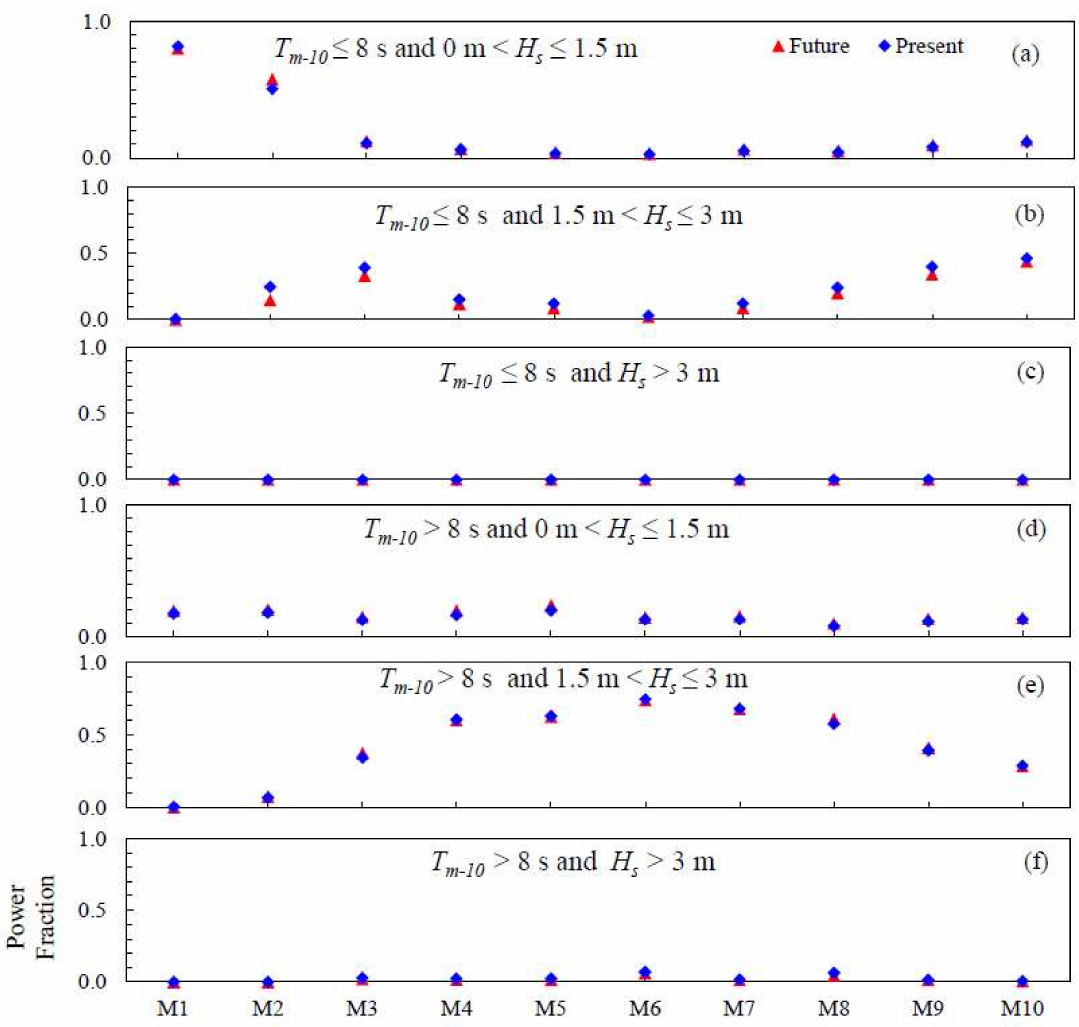
Figure 13. The distribution of available wave power across di ff erent H s and T m-10 classes as a fraction of total available power at points M1 to